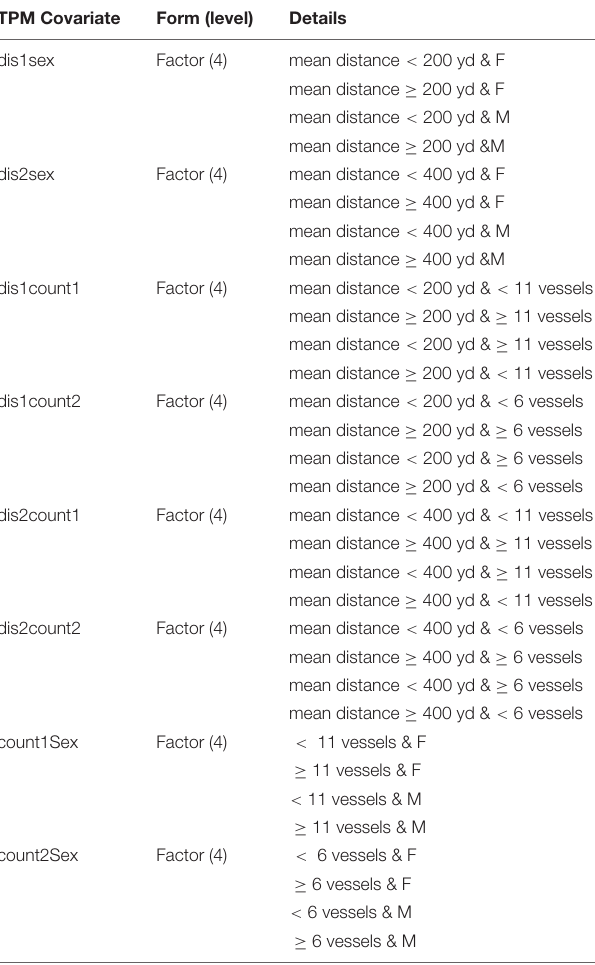
TABLE 4 | Definitions of combined covariates on the state transition probability matrix for candidate